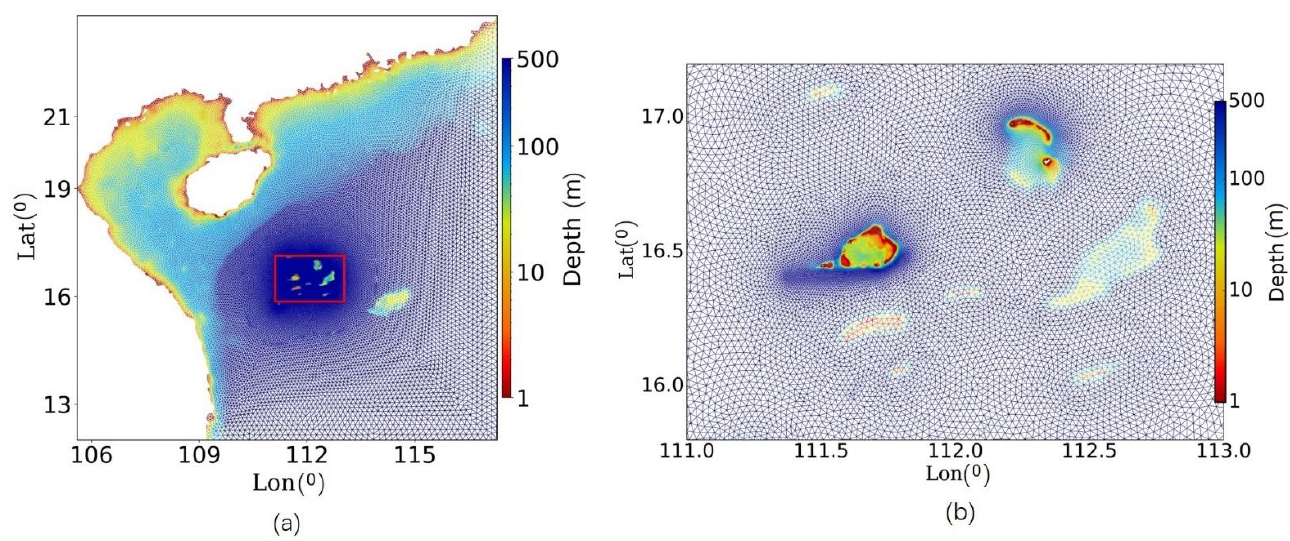
Figure 2. ( a ) Unstructured grid of the South China Sea. The resolution varies from 3 km to 300 m. ( b ) Regional numerical grid of the Xisha Islands. The color scale indicates the water depth.